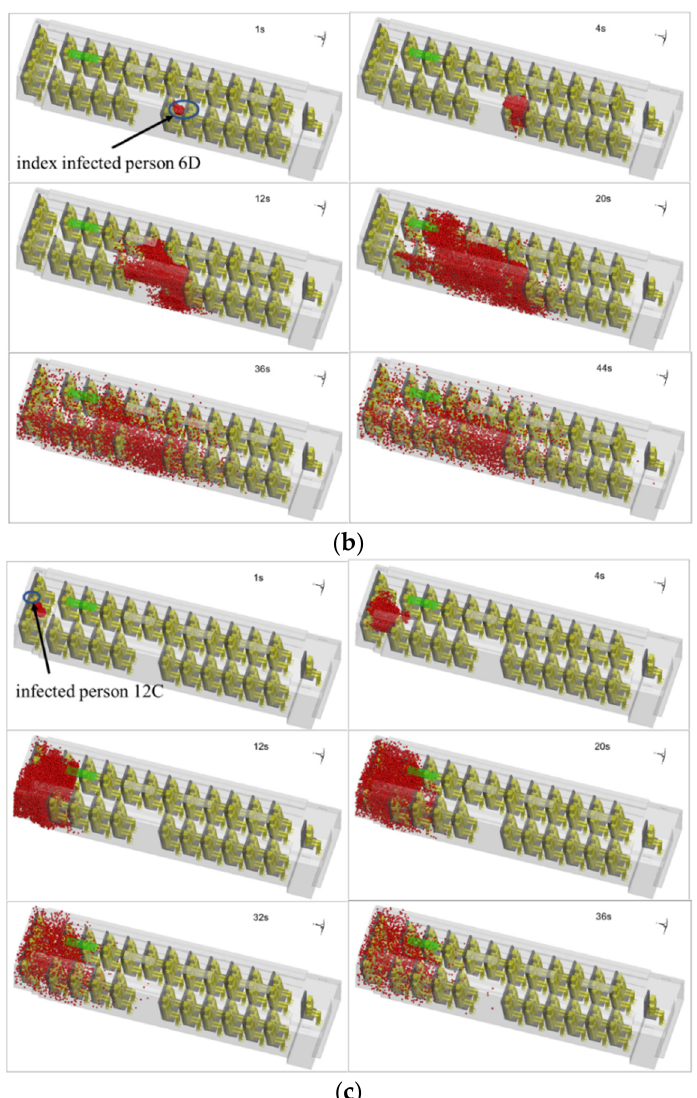
Figure 10. The distribution of droplets released from the index infected person’s cough over time, ( a ) Case 4.1, ( b ) Case 4.2, ( c ) Case 4.3.